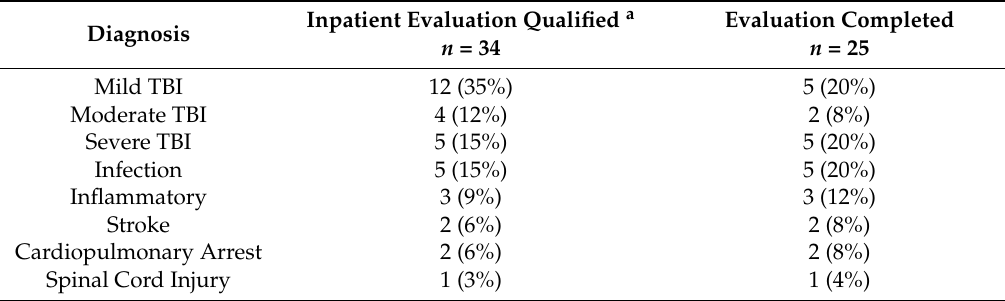
Table 2. Inpatient neuropsychology evaluation by diagnosis.